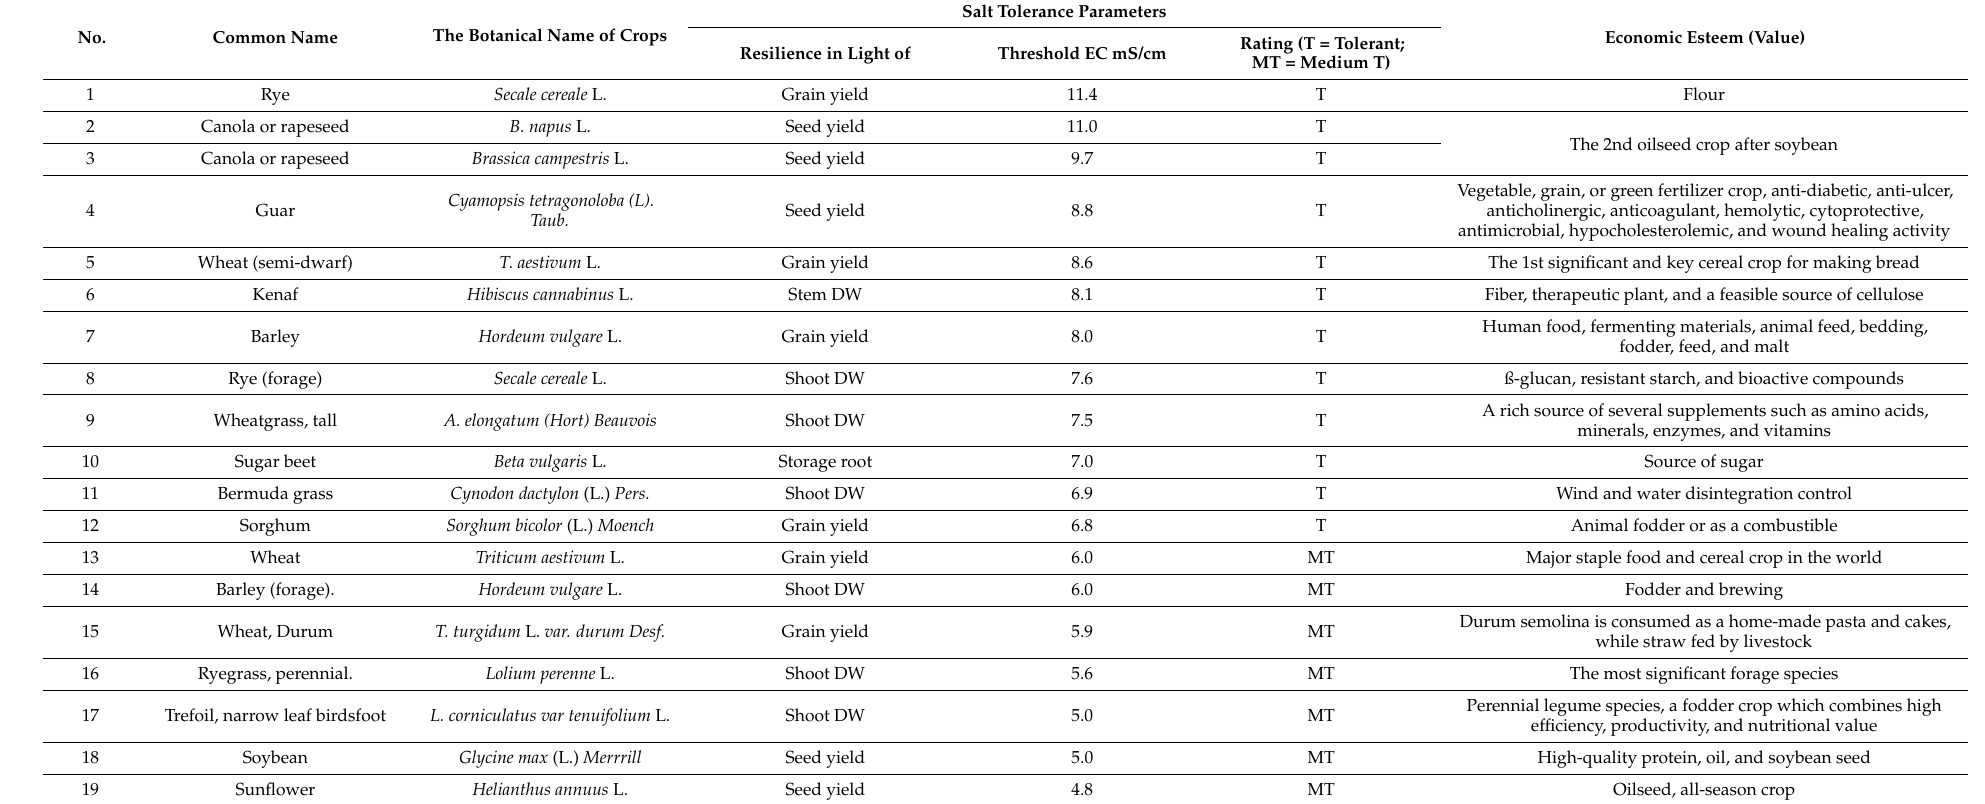
Table 1. Examples of salt resilience of herbaceous